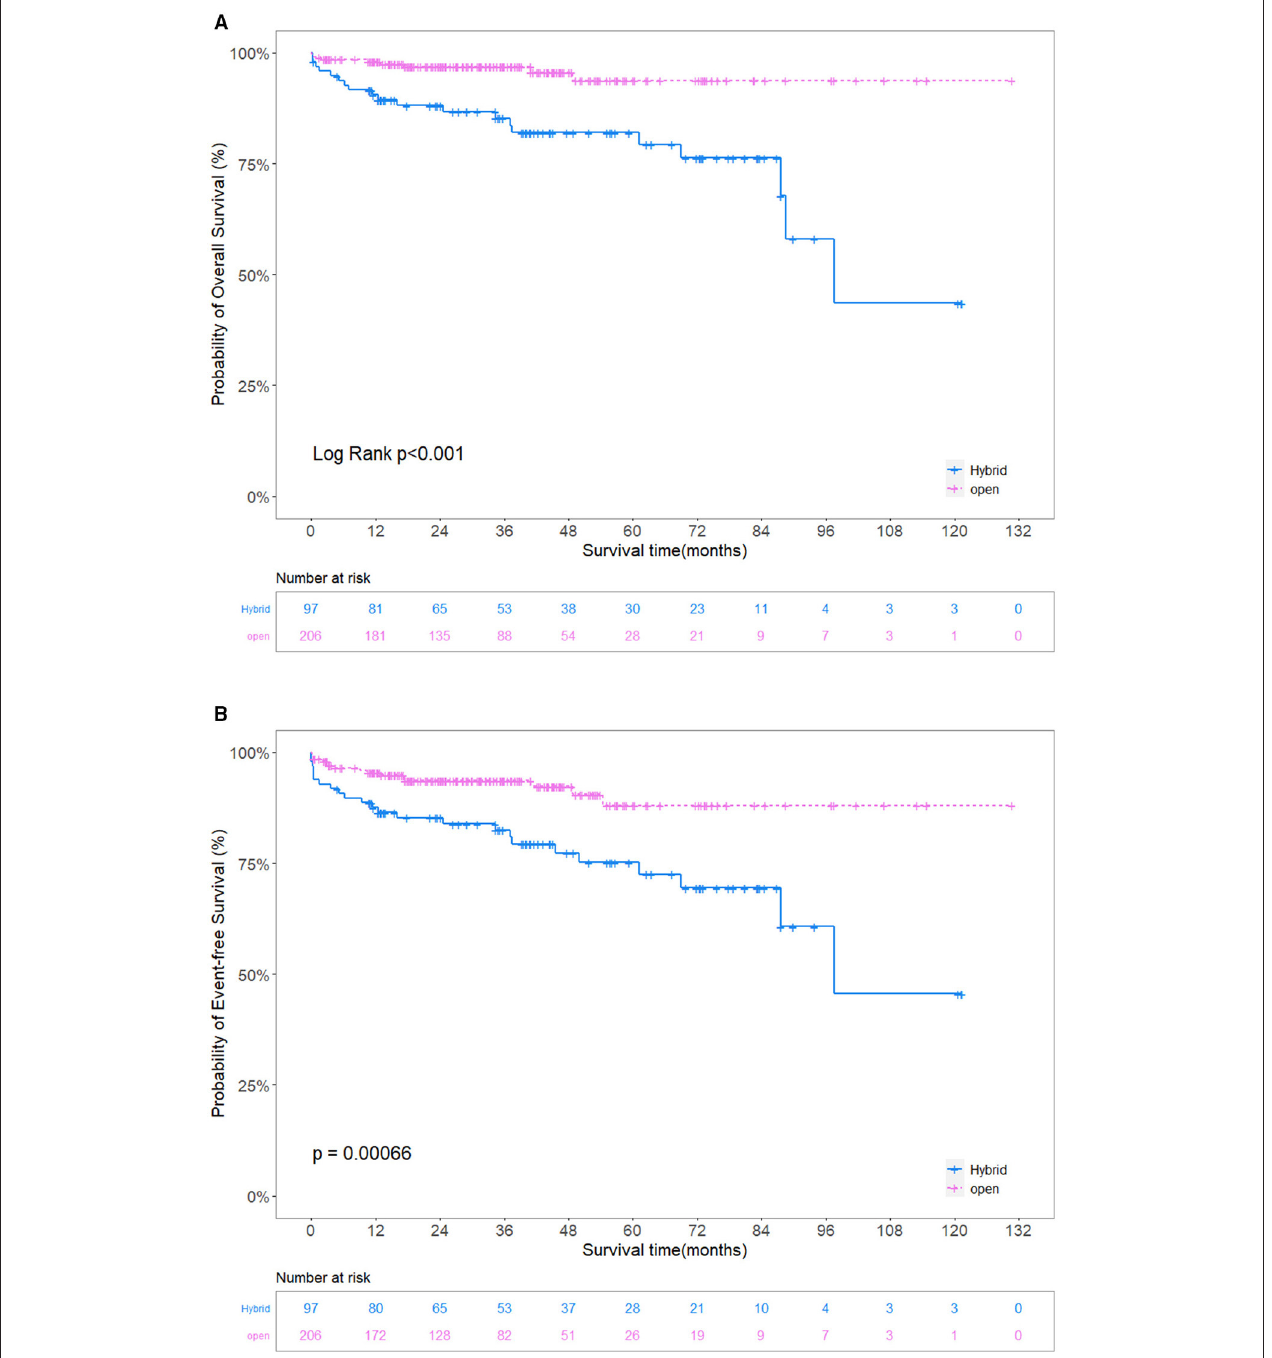
FIGURE 4 | (A) Unadjusted comparison of the overall survival. (B) Unadjusted comparison of the event-free survival. The overall survival and event-free survival in the SET group were significantly better than those in the HAR group. SET, stent elephant trunk procedure combined with supra-aortic branch reconstruction; HAR, hybrid procedure combined TEVAR with extra-anatomic